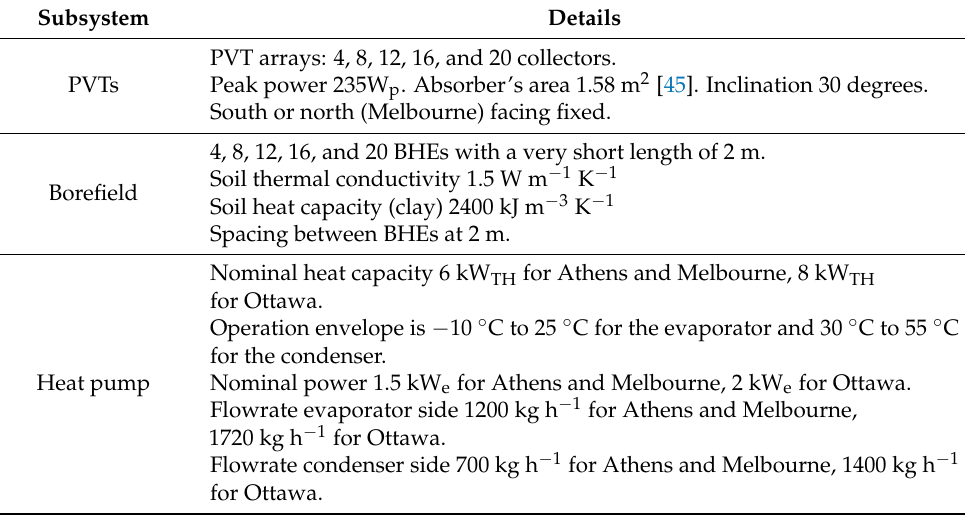
Table 2. Main system